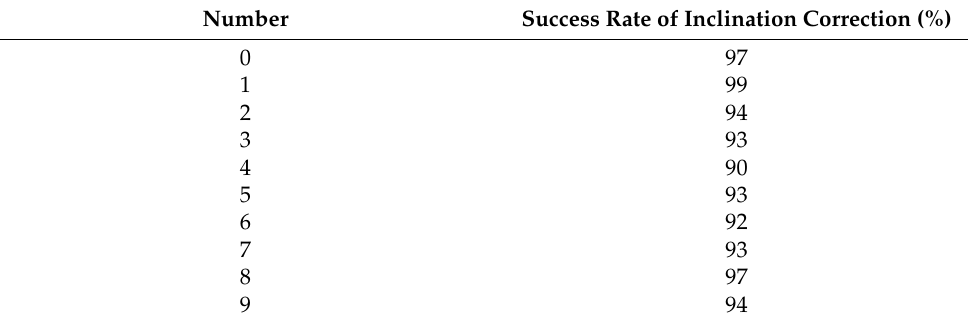
Table 2. Success rate when the inclined angle is within 30 ◦